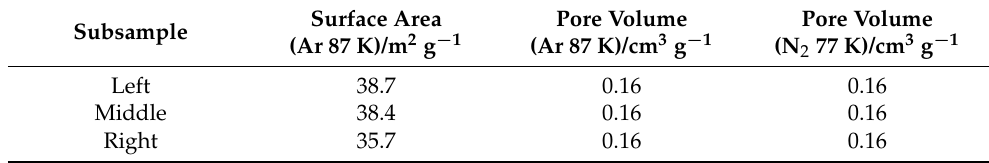
Table 1. Textural properties of the three subsamples (left, middle, right) of the thin-layer porous structure. The surface areas determined by the BET method based on Ar 87 K adsorption for a relative pressure range from p / p 0 = 0.05–0.3. Pore volume (N 2 77 K and Ar 87 K) was determined using the Gurvich equation at p / p 0 = 0.98 with